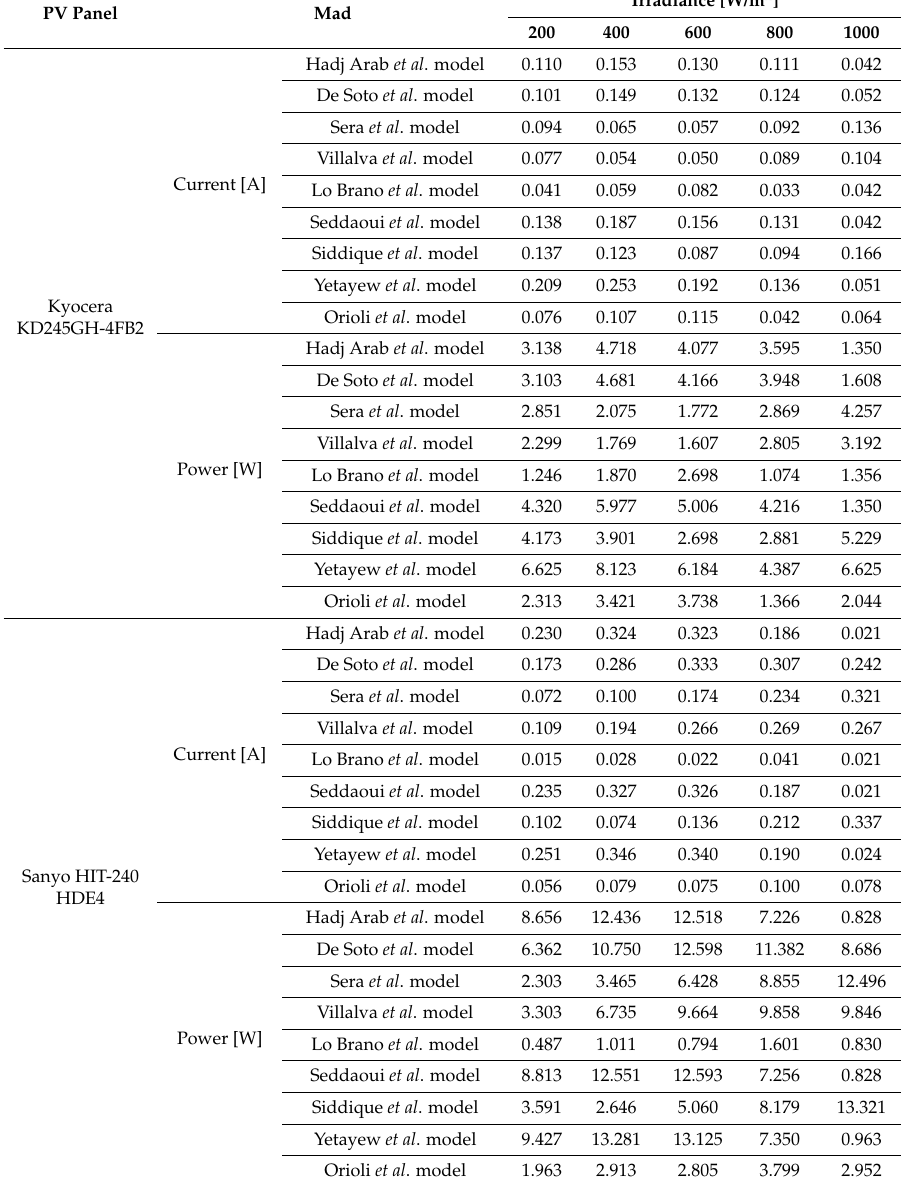
Table 5. Mean absolute current and power differences between the calculated and the issued I–V characteristics at temperature T = 25 ˝